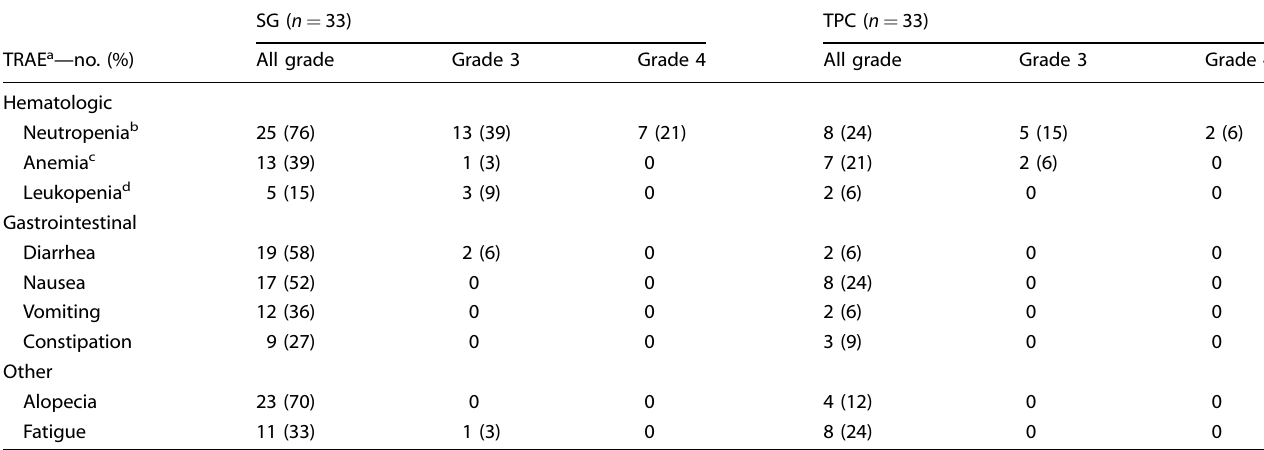
Table 2. Treatment-related adverse events (all grade, >20%; grade 3/4, >5% of patients) in the second-line